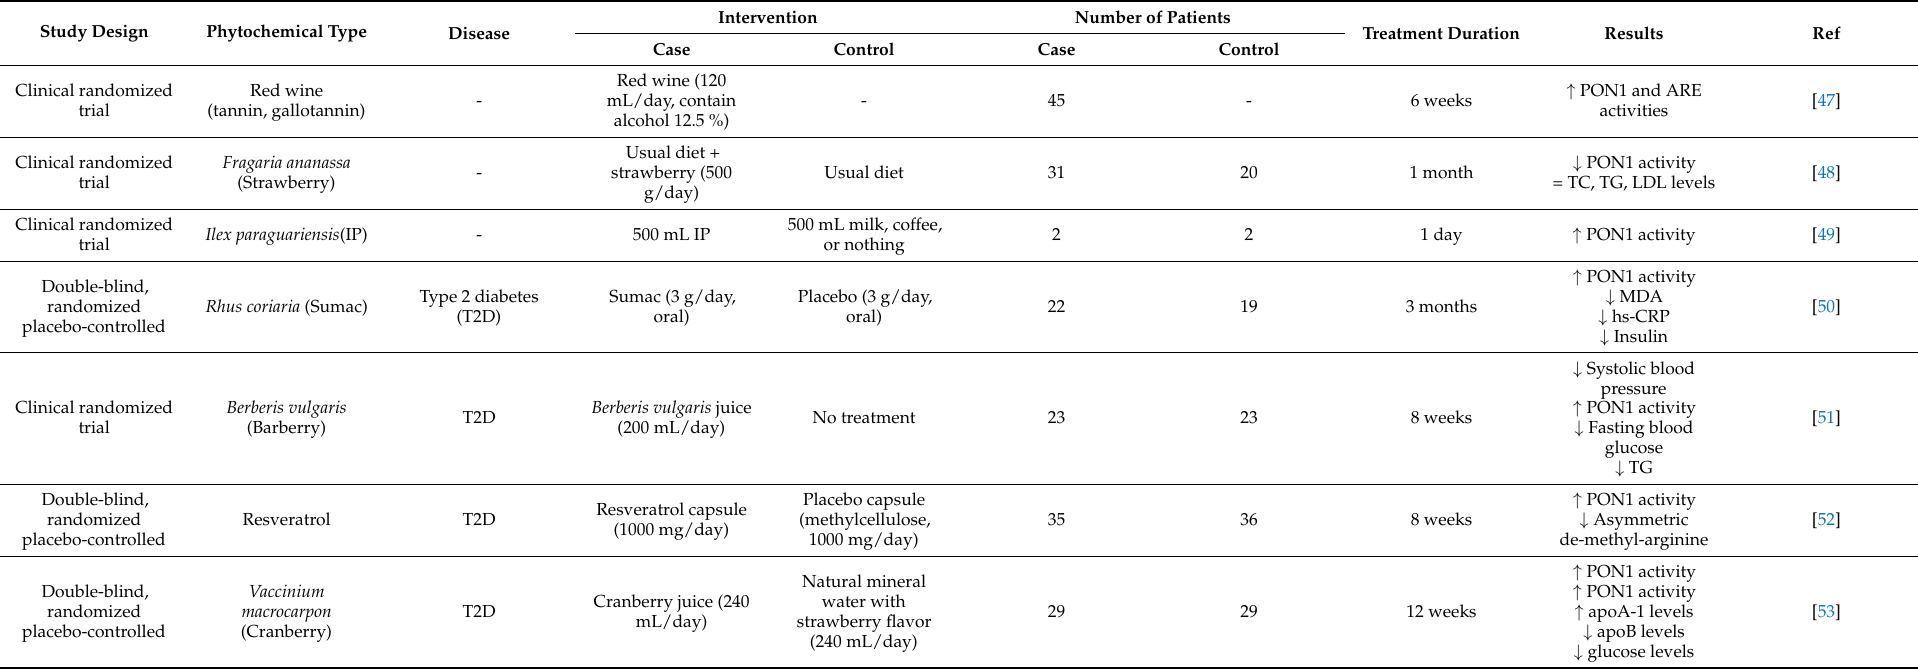
Table 3. Effects of phytochemicals on PON1: clinical